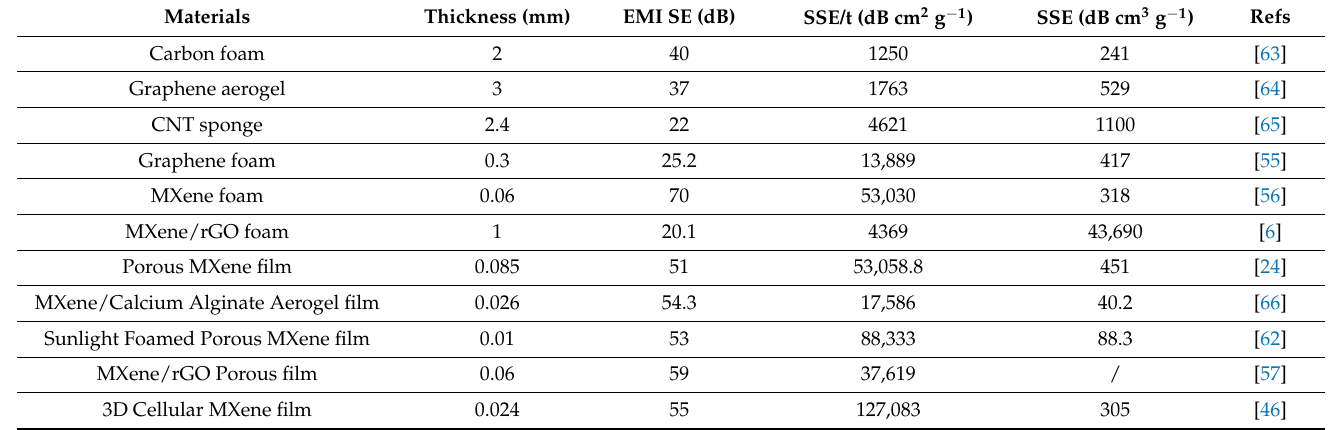
Table 1. Comparison of EMI shielding performance for typical porous materials.